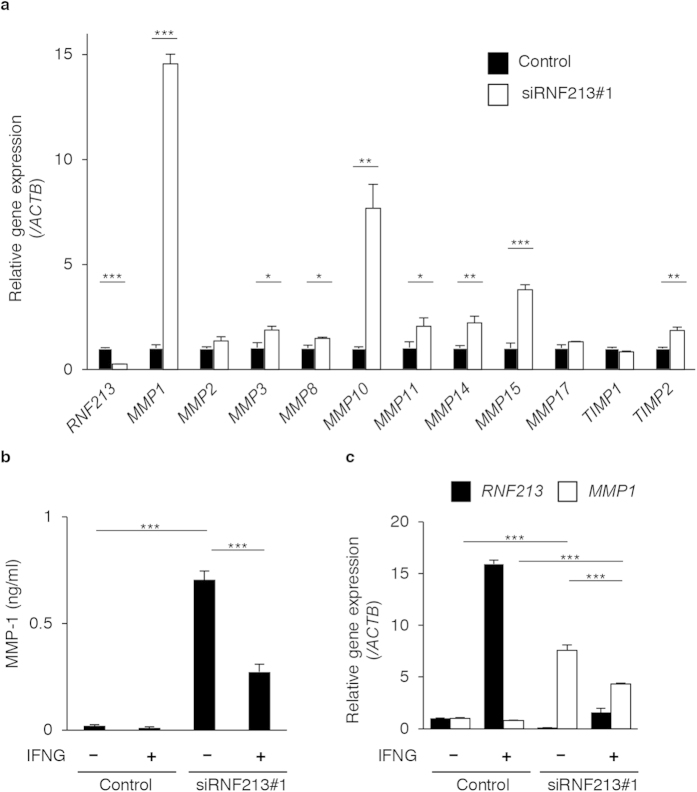
RNF213 controls the expression of MMPs in endothelial cells.(a) Relative expressions of RNF213, MMPs, TIMP1 and 2 genes are plotted. Note the significant up-regulations of all but MMP2, 17, TIMP1 genes with knockdown of RNF213 (white bars) compared to control experiments (black bars). Data are show as values of mean ± SD (n = 3) and analyzed using Student’s t-test. *p < 0.05, **p < 0.01, ***p < 0.001. (b) Secreted MMP1 proteins in the culture medium. Data from three independent assays with ELISA are shown (mean ±SD). Note that MMP1 proteins are significantly elevated with knockdown of RNF213 regardless of IFNG pretreatments. The elevation of MMP1 with RNF213 knockdown are partly attenuated by IFNG pretreatments (IFNG+) compared to that in untreated cells (IFNG−), using Tukey’s HSD test. ***p < 0.001. (c) Preventative effects of IFNG on aberrantly up-regulation of MMP1 RNA due to RNF213 knockdown. The data from three independent experiments followed by qPCR are shown and analyzed using Tukey’s HSD test. ***p < 0.001.